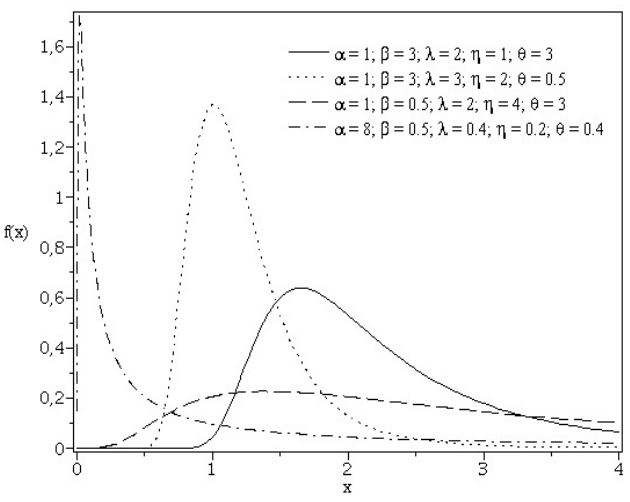
Fig. 1. The PDF of the EKIW distribution for different values of the